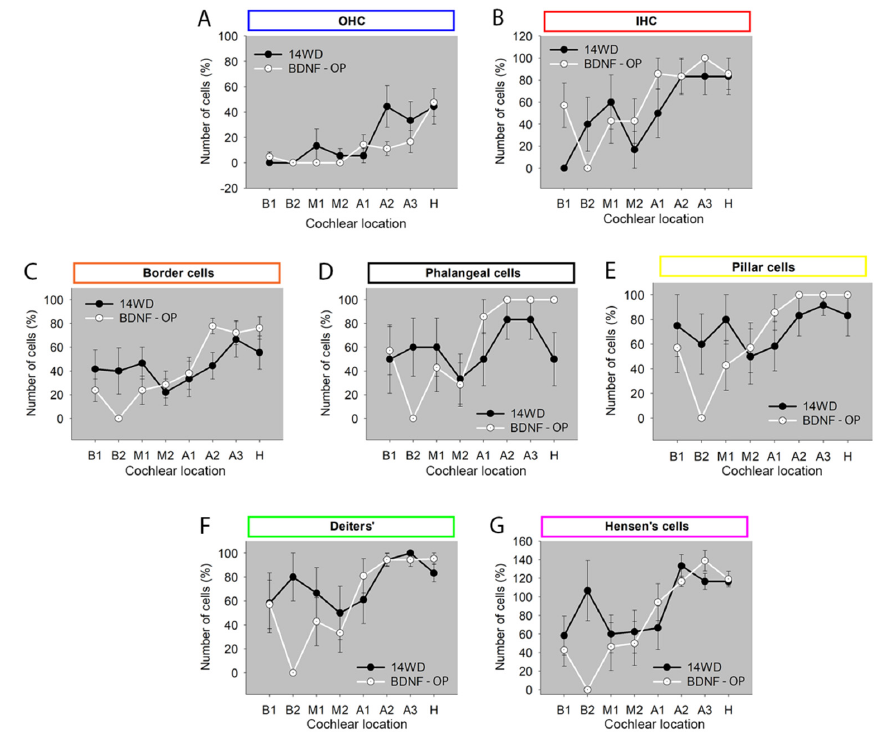
Figure 8. Cell count of sensory and non-sensory cells in the organ of Corti of BDNF-OP ears over all cochlear locations. Cell count of ( A ) outer hair cells (OHC), ( B ) inner hair cells (IHC), ( C ) border, ( D ) phalangeal, ( E ) pillar, ( F ) Deiters’, ( G ) Hensen’s cells. Graphs are shown as mean ± SEM (14WD: n = 6; BDNF-OP: n = 7) and show cell count of each cell type for each cochlear location of BDNF-treated (BDNF-OP) and PBS-treated ears (14WD). Number of cells is expressed as percentage of NH (100%).